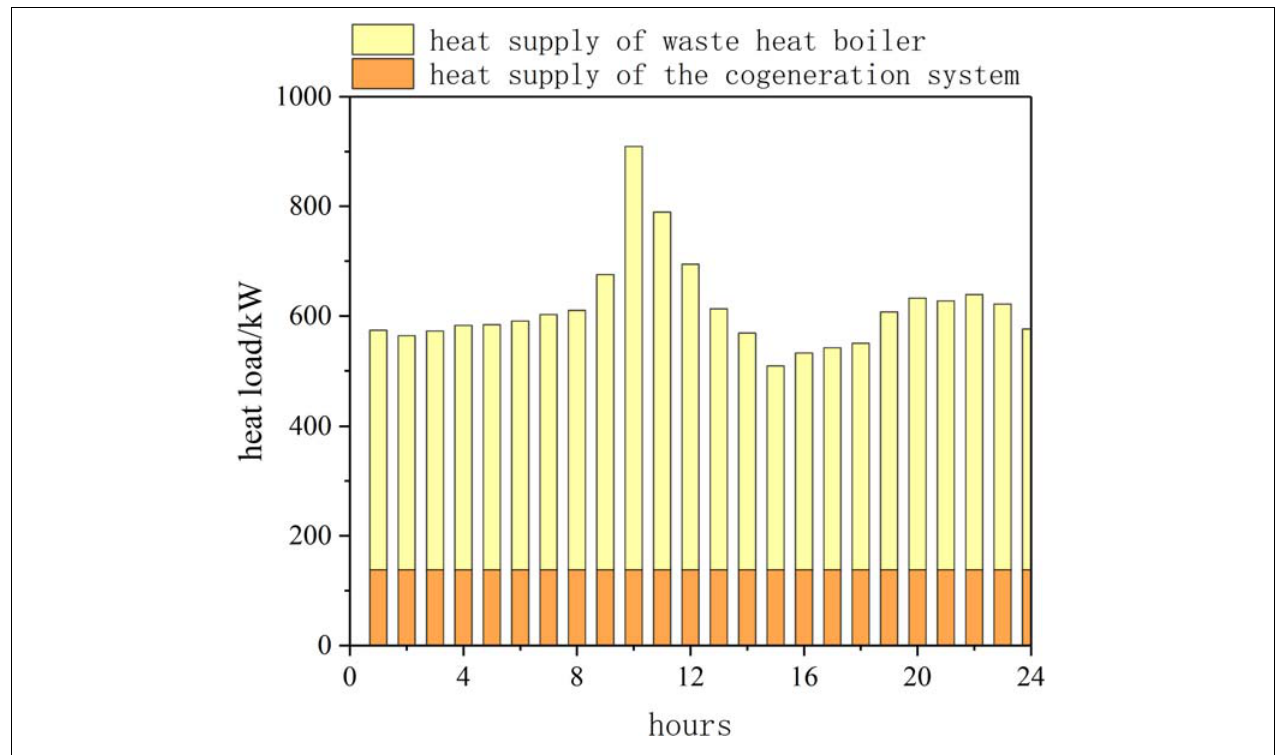
FIGURE 9 | Thermal energy supply on a typical winter day.